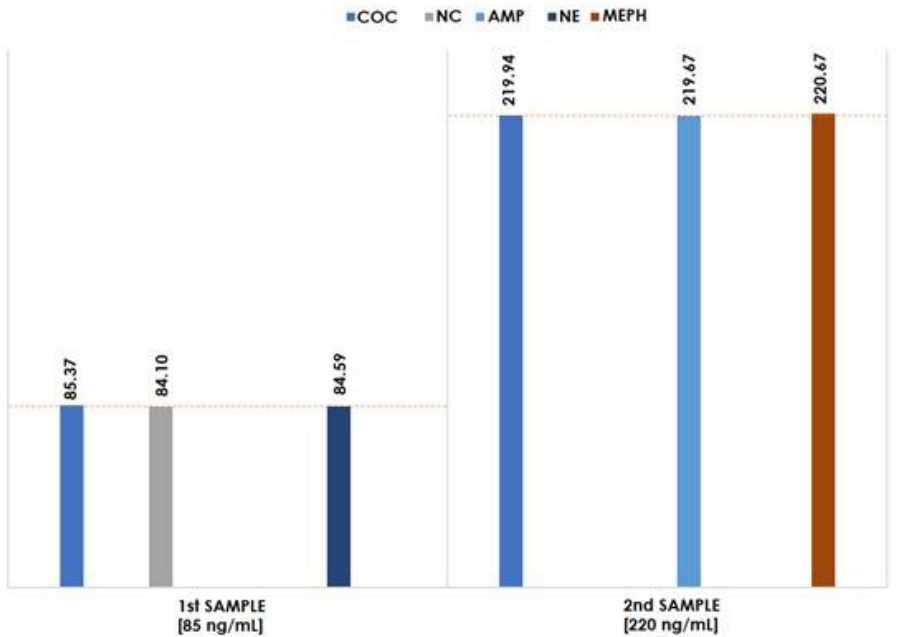
Figure 3. Results of intra-laboratory test for bone marrow samples and their comparison between the obtained and expected concentration of the narcotics tested.